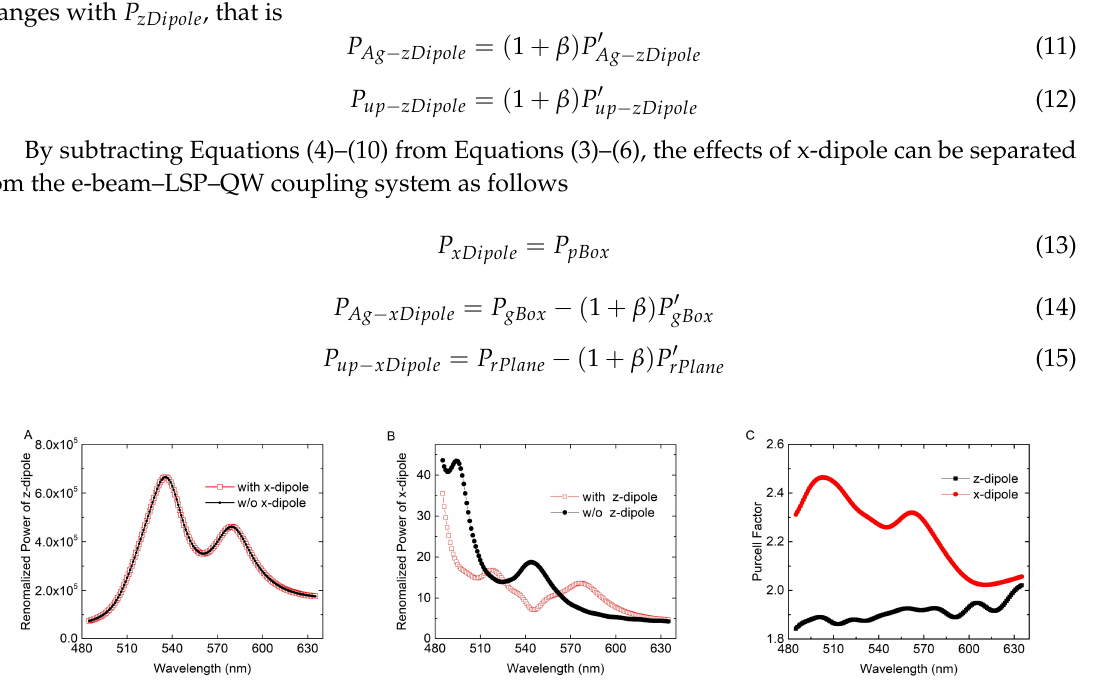
Figure 6. Renormalized powers vs. wavelengths of ( A ) z-dipole with and without x-dipole and ( B ) x-dipole (i.e., Fp in this case) with and without z-dipole at impinging point B; ( C ) Purcell factor for the x-dipole and z-dipole without the Ag